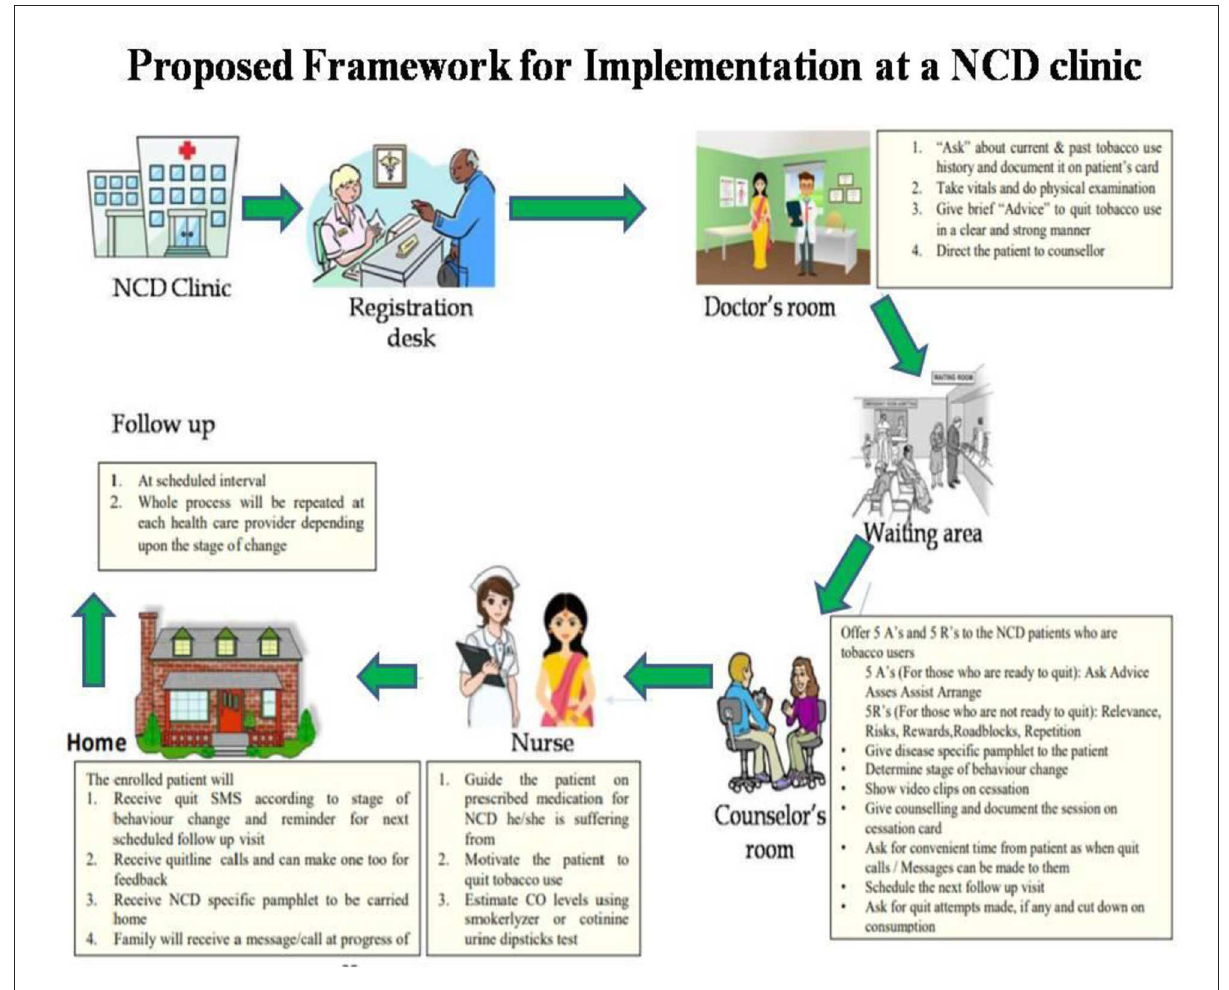
FIGURE2 Proposed implementation framework at NCD